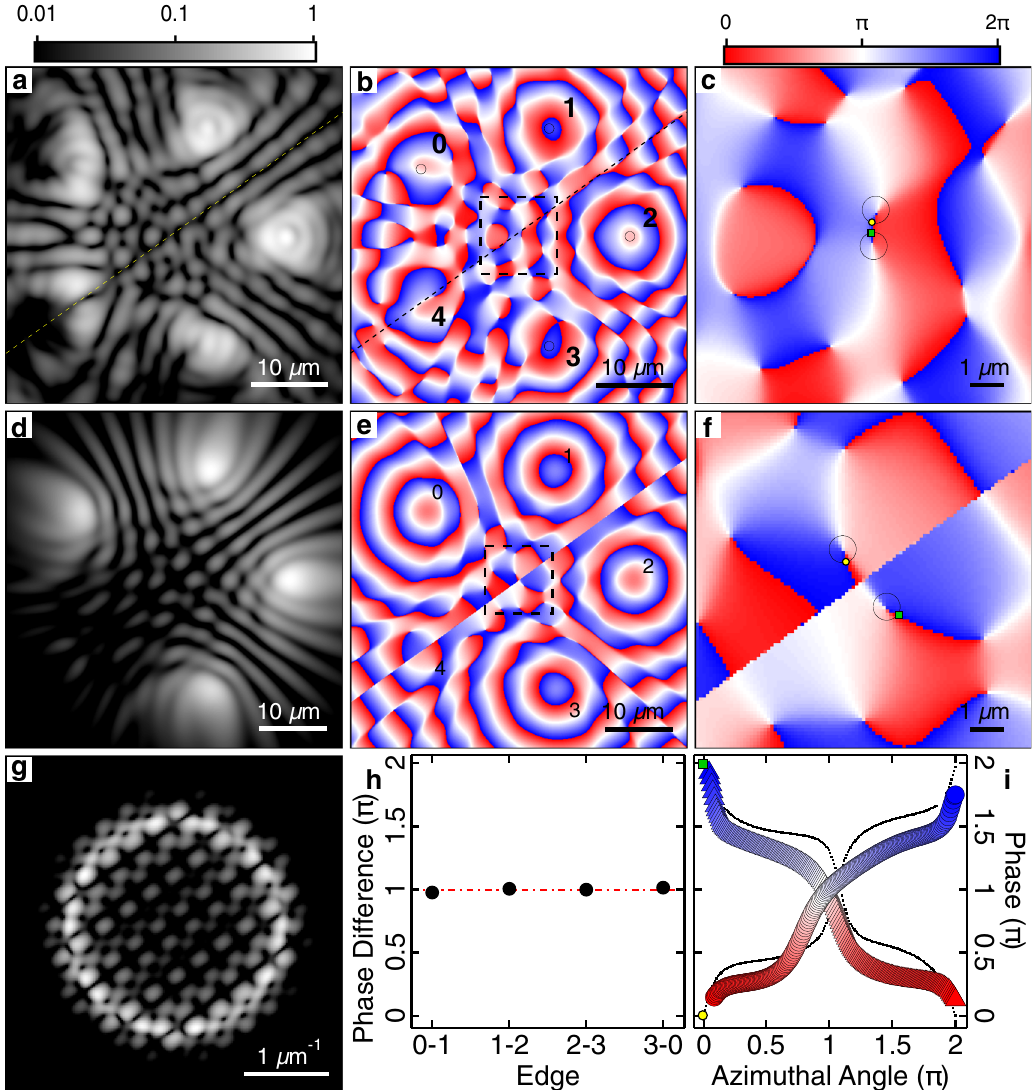
Fig. 5 Single shot of a pentagon of polariton condensates with one fractured condensate. Pentagon condensate with a ∣ m ∣ = 1 vortex – antivortex pair. a Experimental real-space PL and b , c phase extracted from interferometry from a single instance of the condensate. Simulated steady-state vortex – antivortex wavefunction d real-space density, e , f phase and g Fourier-space density. c , f Zoomed-in regions of the dashed squares in b , e , respectively. h Phase difference between different condensates (black dots) in the polygon extracted from the black circles in b . i Line pro fi les extracted along the two dashed circles in c , f . Yellow and green markers correspond to azimuthal angle equal to zero. Experimental data are represented by the coloured disks and numerical simulation by the black-dotted curves. Image a is saturated at a lower limit of 0.04 to allow for better visibility of the